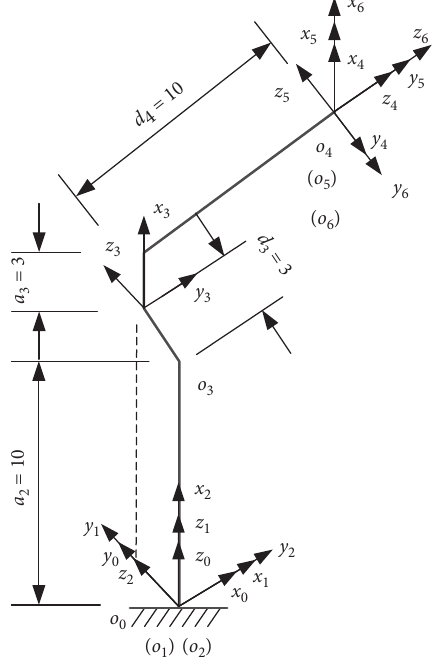
Figure 1: ZrARM arm improved DH model coordinate